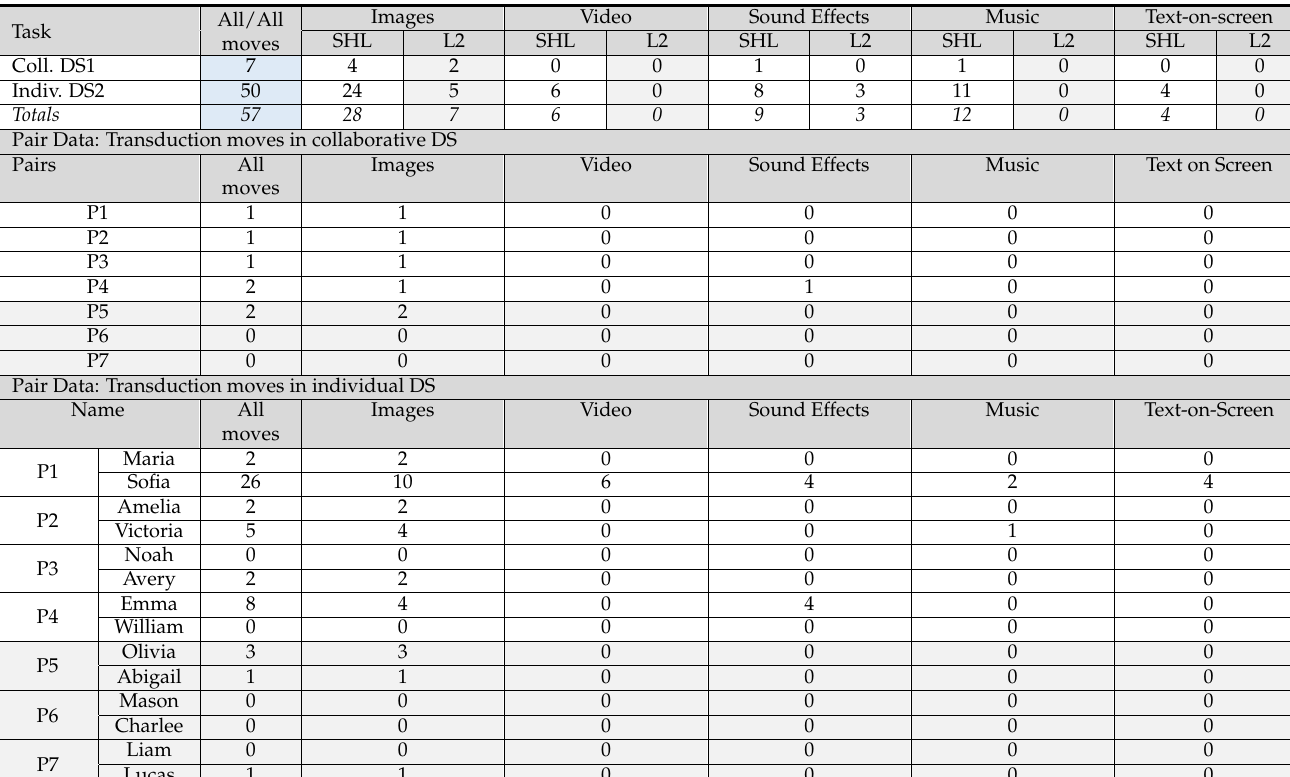
Table 8. Summary of the number of transduction moves across